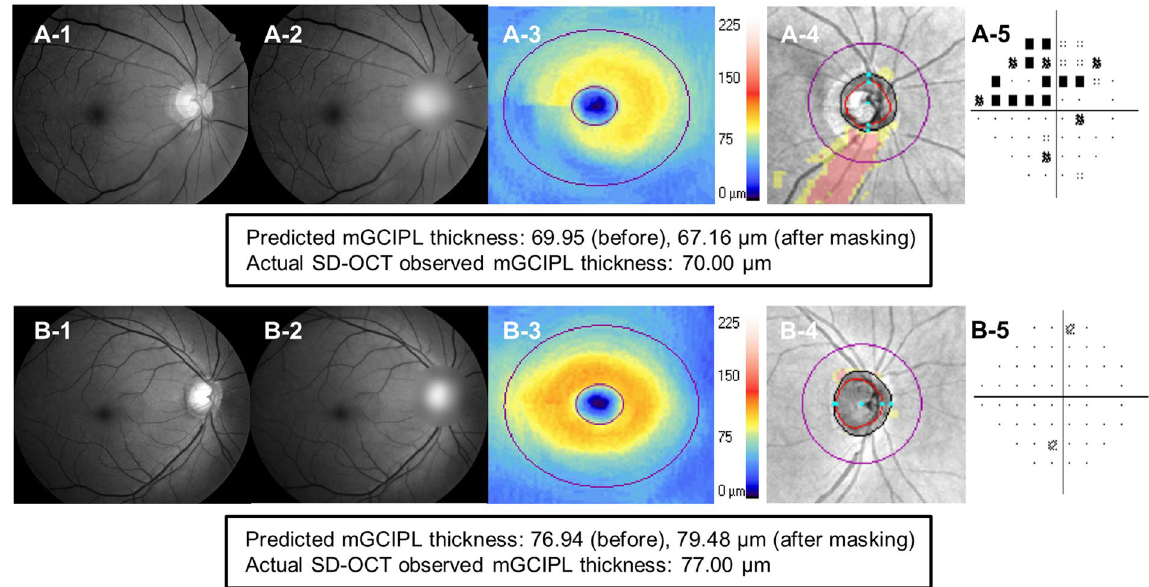
Figure 5. Representative glaucomatous and non-glaucomatous cases. (A) Glaucomatous eye of 69-year-old woman. (A-1) Red-free RNFLP. A distinct inferior RNFL defect is shown. (A-2) RNFLP with peripapillary area masking. (A-3) On the mGCIPL thickness map, glaucomatous inferotemporal mGCIPL thinning is evident. (A- 4) RNFL deviation map. (A-5) Pattern deviation plot reveals superior hemifield defect. The mGCIPL thickness was predicted to be 69.95 μ m, and the actual thickness was measured to 70.00 μ m. After masking of the peripapillary area, the prediction was changed to 67.16 μ m. (B) Healthy eye of 53-year-old man. (B-1) The red- free RNFLP showed no definite structural damage. The mGCIPL thickness map (B-3) and RNFL deviation map (B-4) also showed normal findings. (B-5) The pattern deviation plot also indicated no evidence of glaucomatous damage. The mGCIPL thickness was predicted to be 76.94 μ m and 79.26 μ m before and after peripapillary area masking (B-2) , respectively, while the actual thickness was measured to 77.00 μ m. (RNFL = retinal nerve fiber layer; RNFLP = retinal nerve fiber layer photograph; mGCIPL = macular ganglion cell-inner plexiform layer; SD-OCT = spectral domain-optical coherence